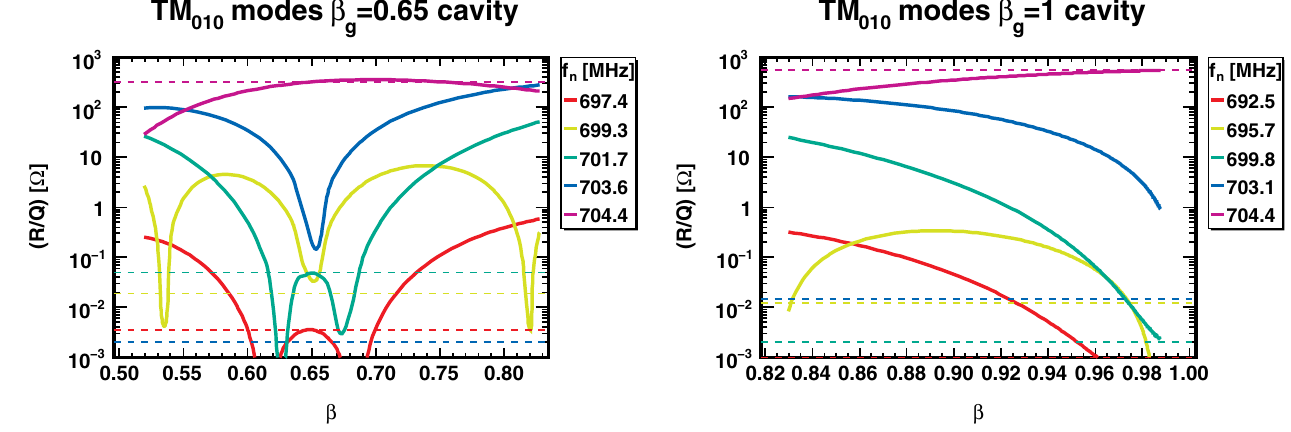
ð (cid:1) Þ map of the TM FIG. 20. ð R=Q Þ modes in the studied cavity. The dashed line is the ð R=Q Þ n 010 geometrical beta, which can differ several orders of magnitude from the maximum ð R=Q Þ